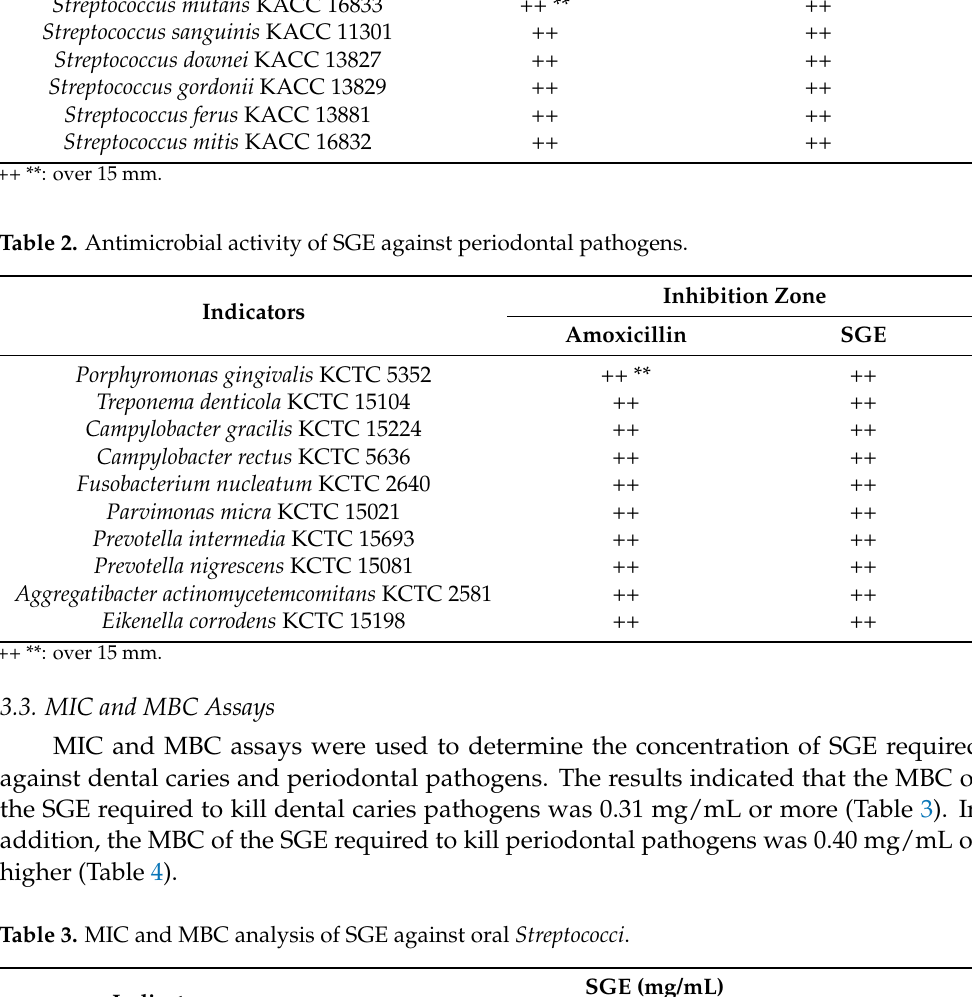
Inhibition Zone Amoxicillin SGE